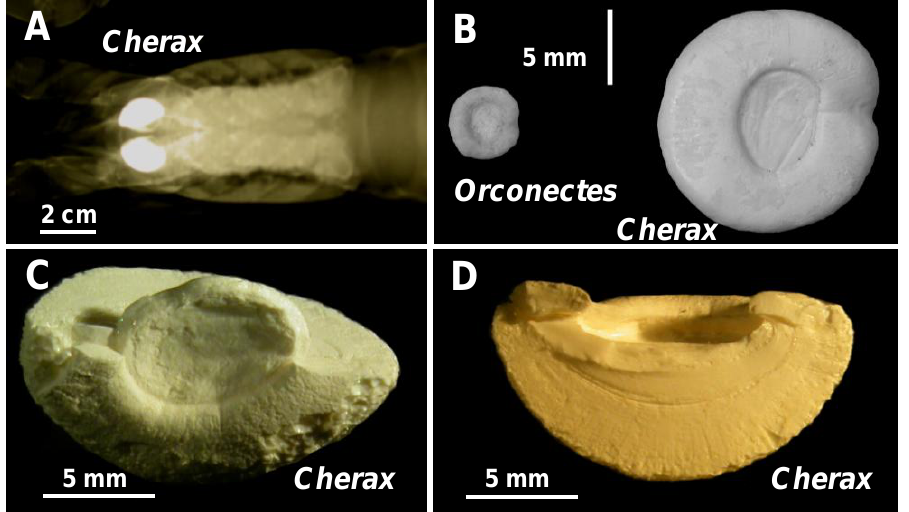
Figure 1. A: Radiography of the anterior part of a Cherax quadricarinatus specimen at the end of the calcium storage process, which occurs all during the premolt, showing the localization of two X-ray dense gastroliths. B: Gastroliths (light microscopy) from Orconectes limosus , at left, and from Cherax quadricarinatus , at right. The macrostructural aspect is similar. The difference of size is proportional to the size of adult specimens of the two species. The flat or slightly concave side on the stomach lumen side is shown. C–D : Broken gastroliths from Cherax quadricarinatus showing the semi- spherical and internal aspect of a gastrolith. C: the flat disc visible in the center corresponds to the oldest part of the gastrolith, i.e. the beginning of the calcium storage. D: The homogeneous dense and striated internal structure is well visible on this cross-section.